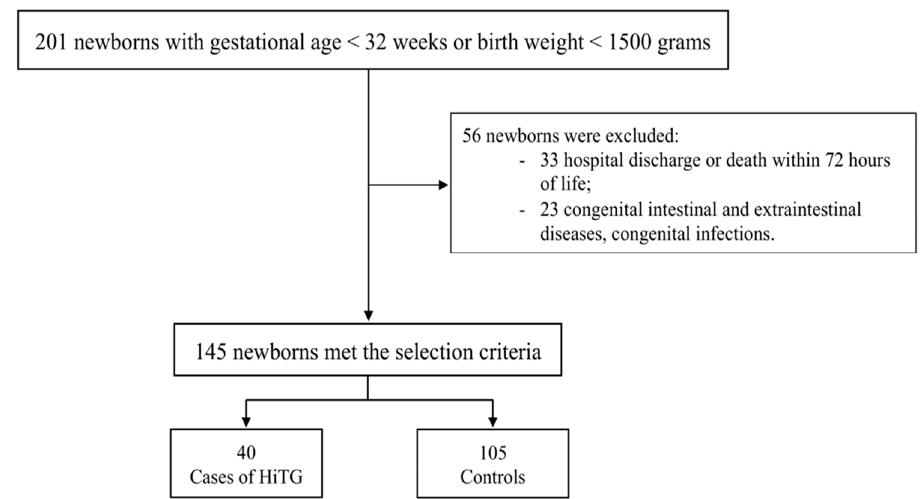
Figure 1. Flow-chart. Notes. HiTG (hypertriglyceridemia).